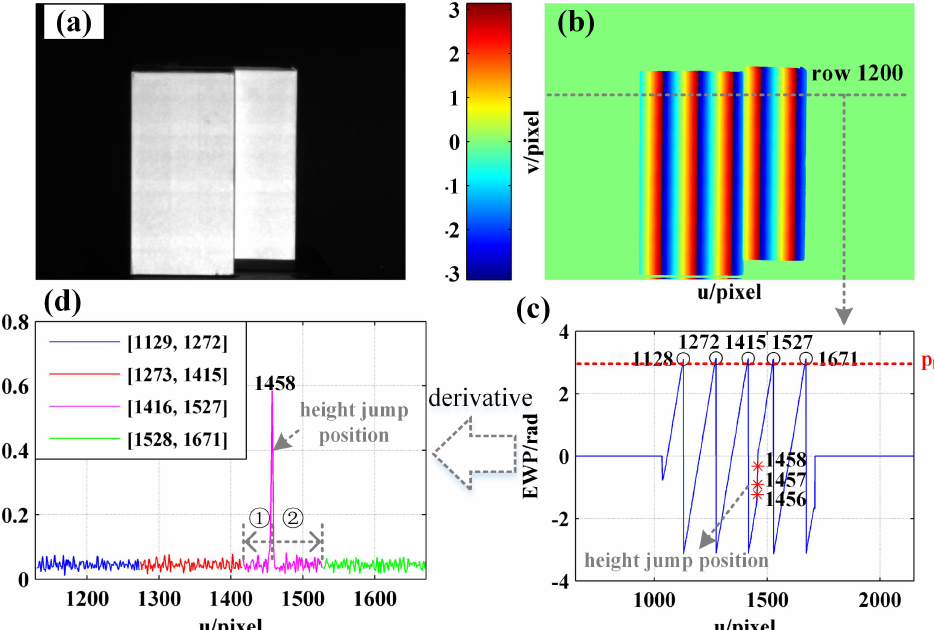
Figure 20. ( a ) Physical map of the step workpiece; ( b ) EWP map with u = [650, 2150] and v = [800,1920]; ( c ) EWP with u = [650, 2150] of row 1200; ( d ) the derivative of ( c ).